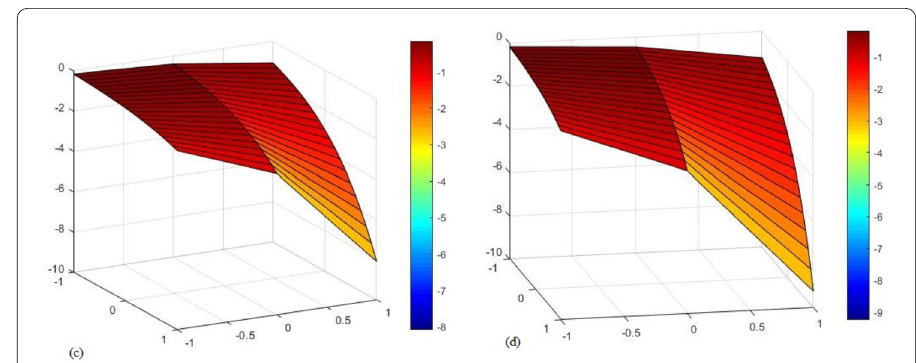
Figure 8 The graph of different approximate solution of (cid:11) ( χ , ϕ , η ) at ϒ = ( c ) 0.8 and ( d ) 0.6 of Example 2